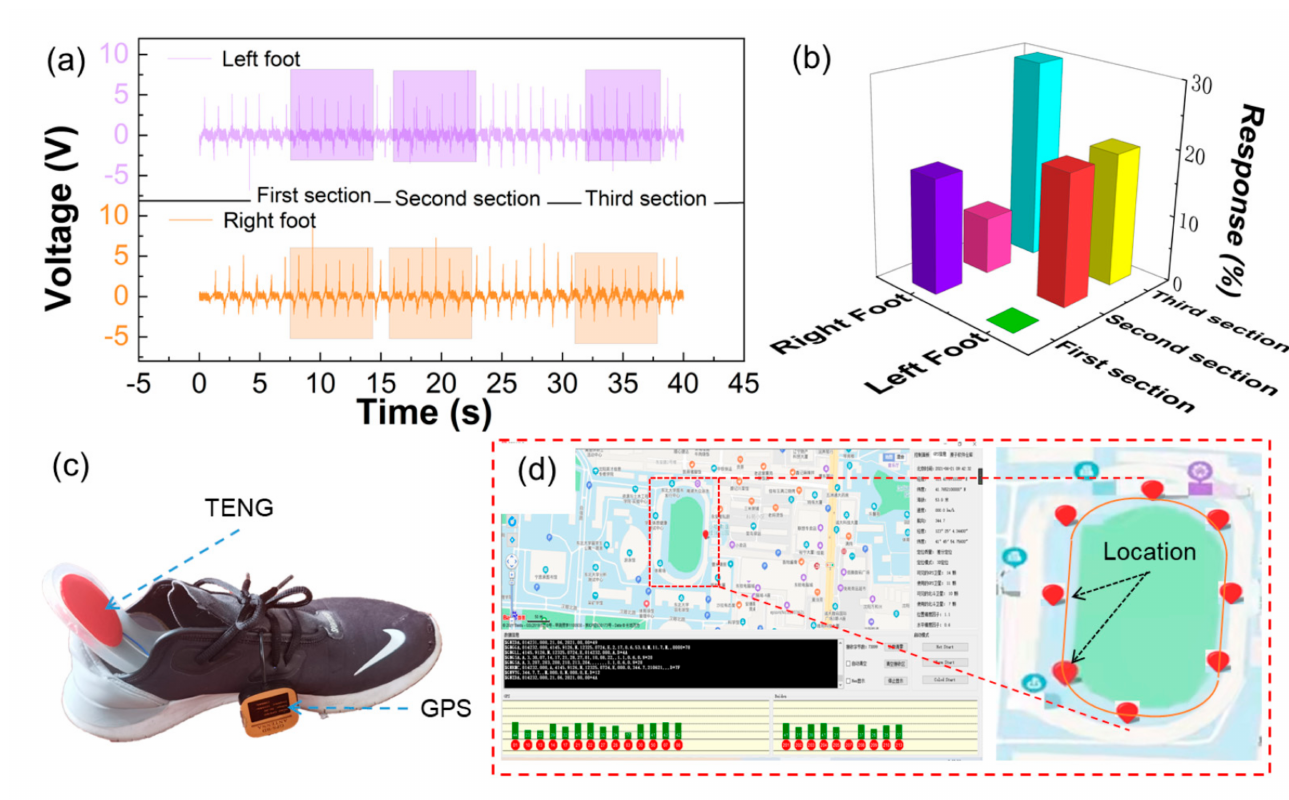
Figure 5. The application of the portable mobile gait monitor system monitor gait balance and driving micro electronic equipment. ( a ) The output voltage of the portable mobile gait monitor system. ( b ) The response of output voltage. ( c ) The portable mobile gait monitor system and micro electronic equipment installation position. ( d ) The e-map of the walking process.